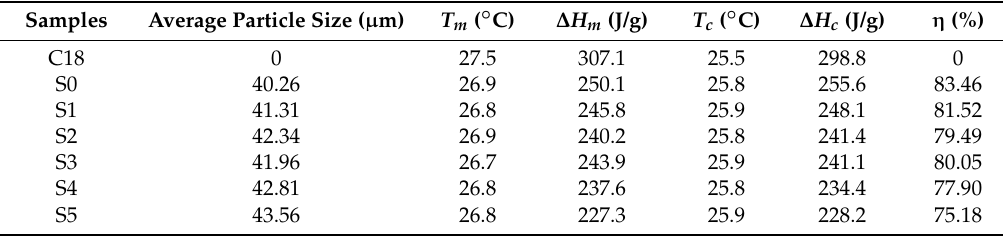
Table 2. The average particle size and phase change properties of the C18 and phase-change microcapsules (microPCMs), incorporated with different amounts of diatomite. microcapsules (microPCMs), incorporated with different amounts of